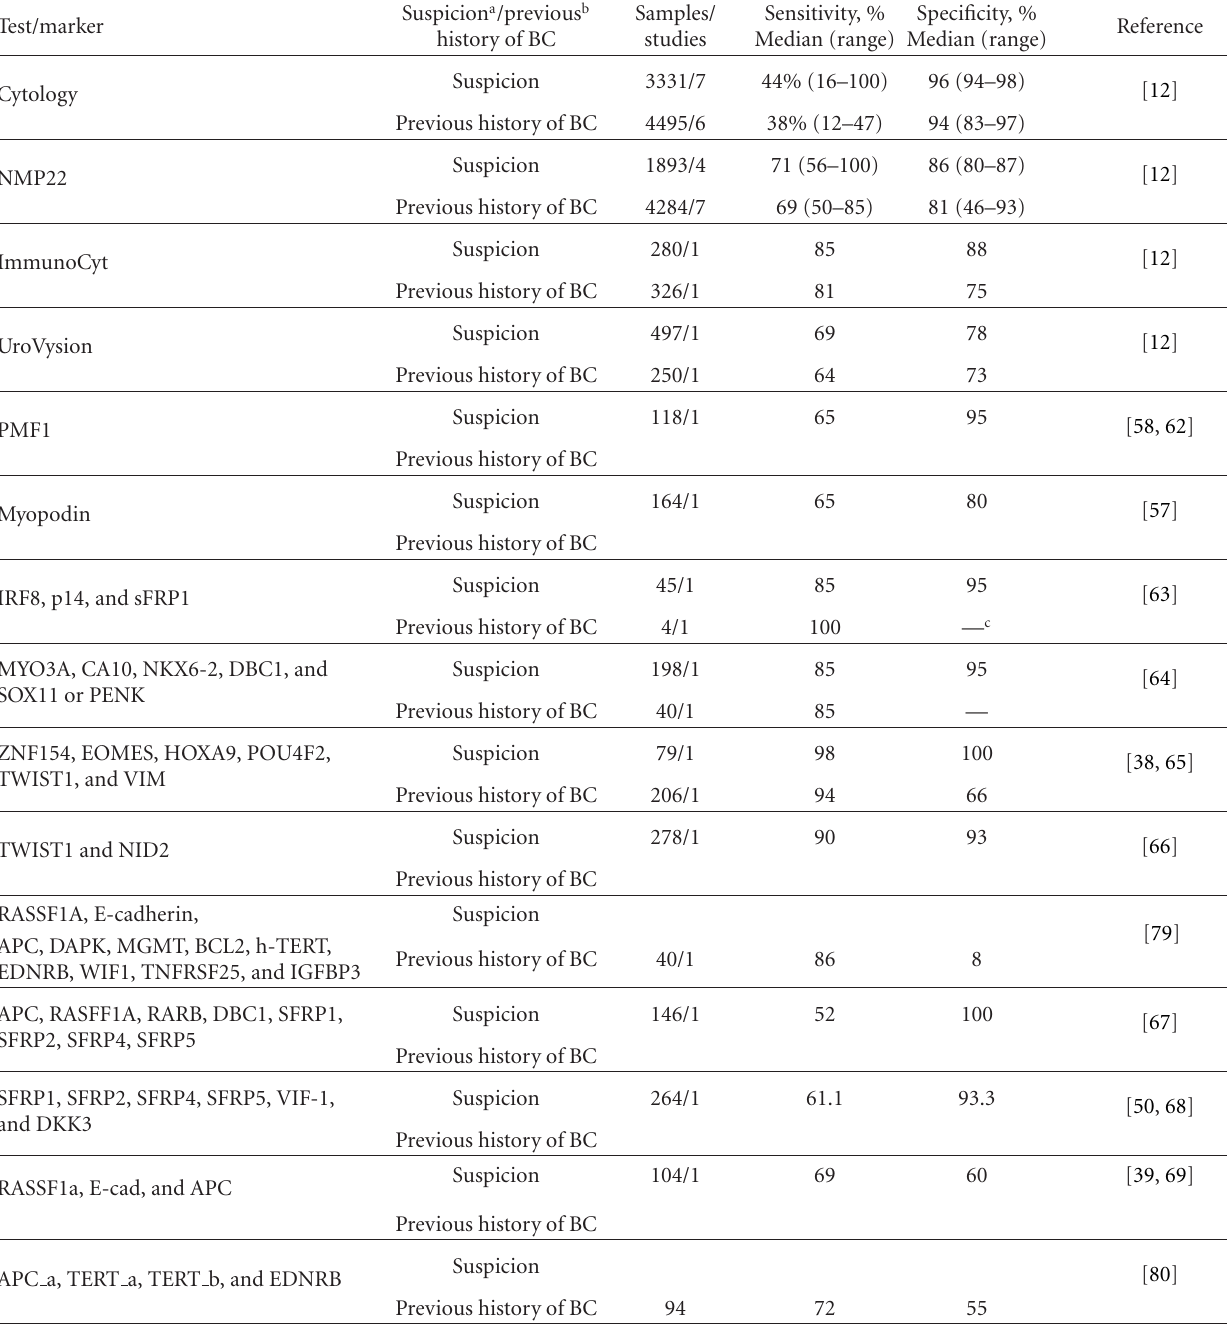
Table 2: Performance of cytology and biomarkers in studies that include patients with suspicion of bladder cancer or patients previously diagnosed with bladder